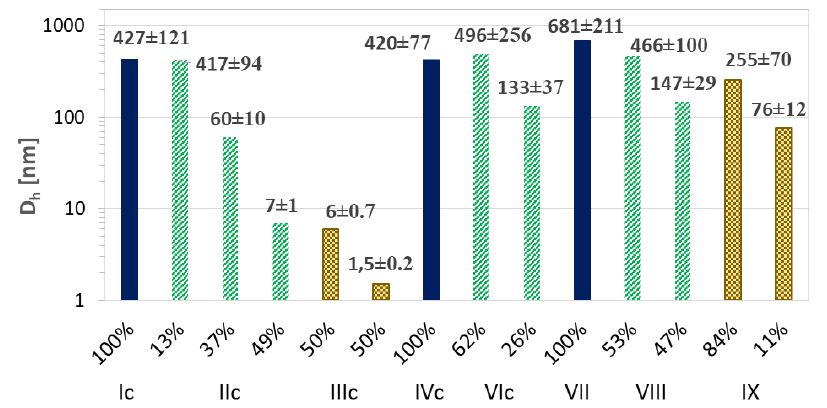
Figure 9. Particle size distribution data for ARB-loaded micellar systems based on intensity calculation method .